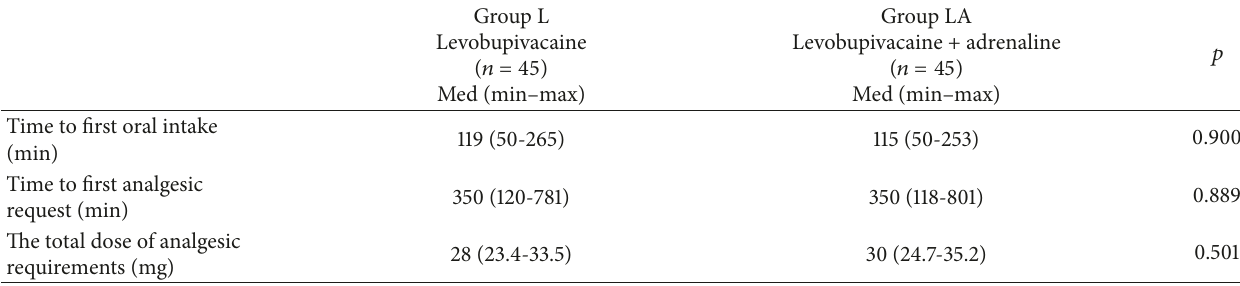
Table 3: The postoperative data and comparative analysis between the two groups.